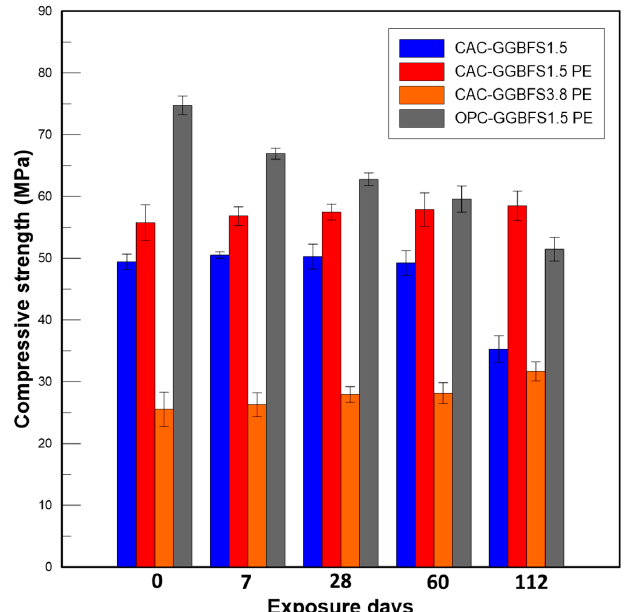
Figure 9. Compressive strength development after sulfuric acid exposure.